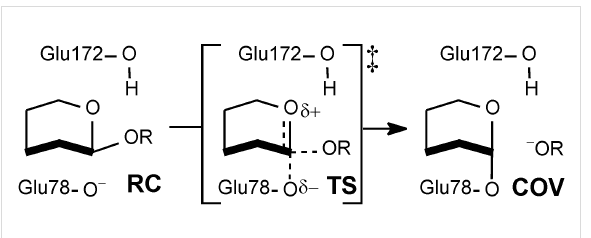
The species S R enz in water is well defined and amenable to computational investigation, although experimentally it is tran- sient and may not necessarily correspond to a genuine inter- mediate. Similarly, species S T enz in water is also well defined and amenable to computational investigation, although – unlike S R enz in water – it was not considered in the previous work [17]. A fair evaluation of the energetic influence of the protein or water environment on the substrate as it changes from the reactant state to the transition state should be made by compari- son of Δ G ‡ enz with Δ G R act + Δ G T dist , since in each case the structures are the same. Owing to the structural distortions of both the reactant and transition states in going from aqueous solution into the enzyme active site, the quantity Δ G T bind − Δ G R bind is an apparent catalytic power which differs from the intrinsic catalytic power Δ G T int − Δ G R int by virtue of the differ- ential distortion energy Δ G T dist − Δ G R dist